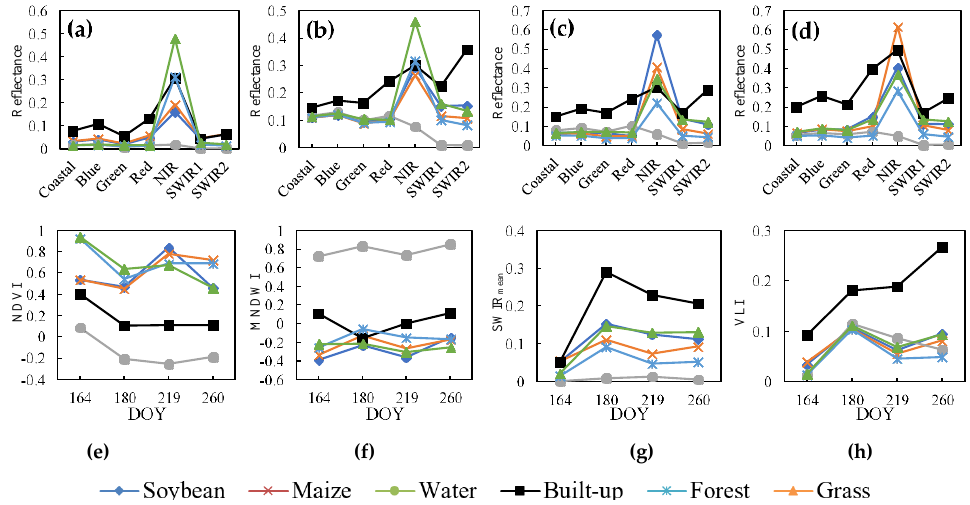
Figure 6. Spectral curves of major classes on DOY 164 ( a ), 180 ( b ), 219 ( c ), and 260 ( d ), and time series of NDVI ( e ), MNDWI ( f ), SWIR mean ( g ), and VLI ( h ).